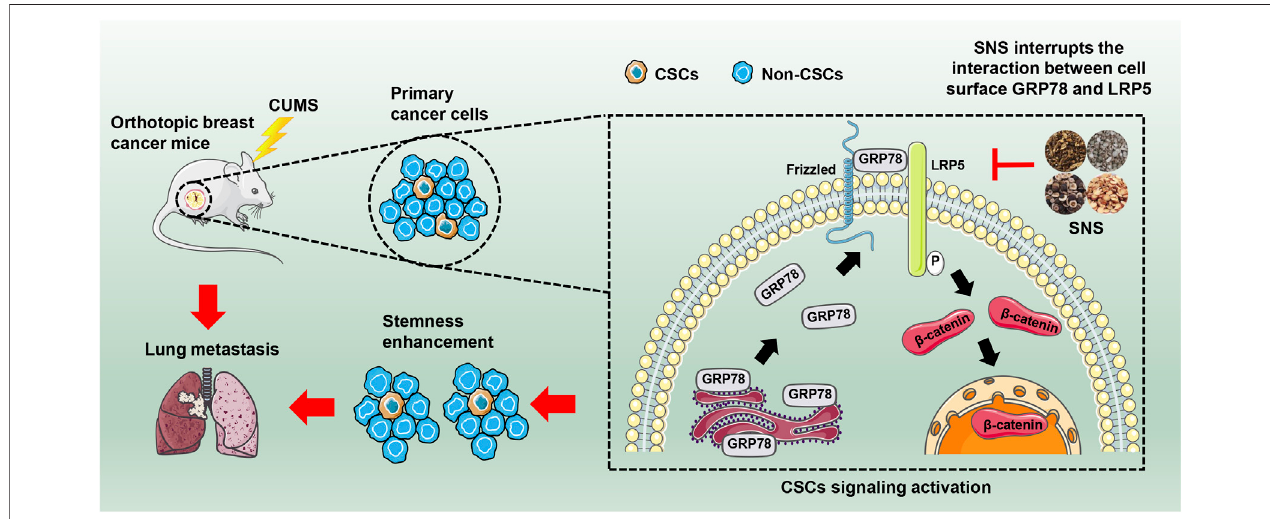
FIGURE 8 | SNS inhibits CUMS-induced lung metastasis and stemness of breast cancer. SNS interrupts the interaction between GRP78 and LRP5 on the cell surface, thus inhibiting the Wnt/ β -catenin signaling of breast CSCs.